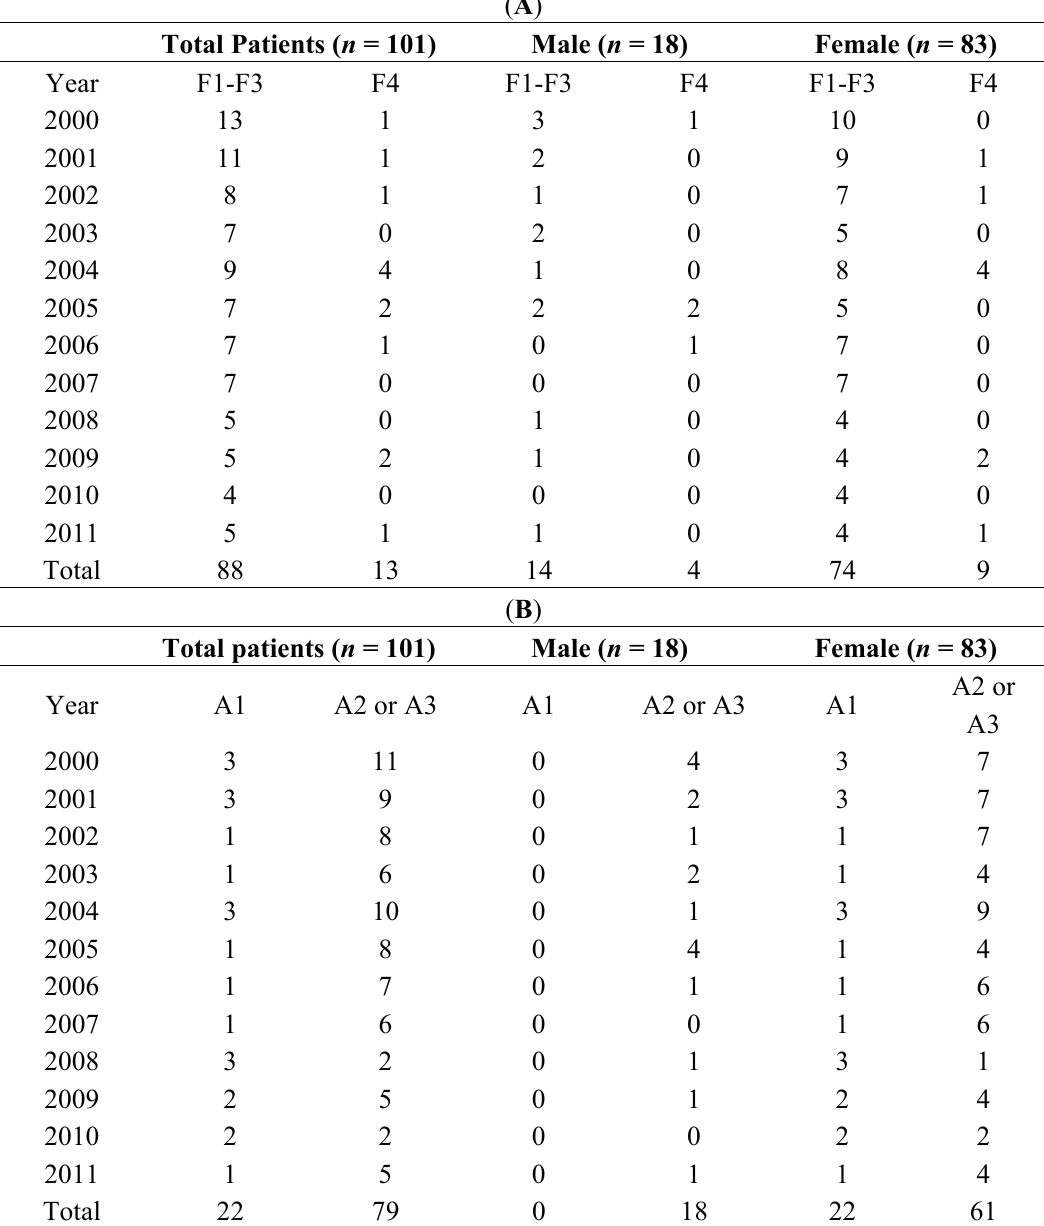
Table 3. Histopathological findings of the liver in autoimmune hepatitis according to gender in the present study. ( A ) Staging of fibrosis; ( B ) Grading of inflammatory